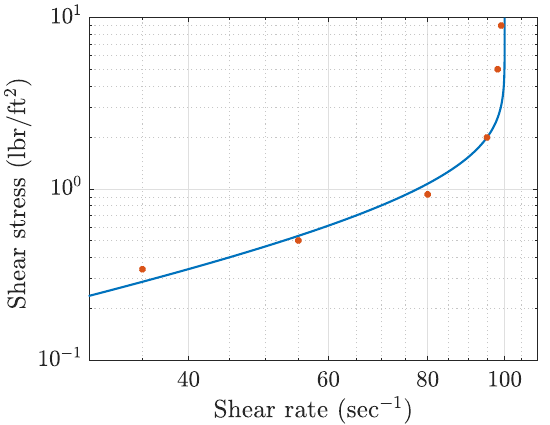
Figure 4. Flow curve (shear stress vs. shear rate) for TiO 2 suspension (47%), see Figure 2 in [1]. Experimental data (stars) and fitting curve (continuous). Fitting parameters a ∗ = 1.5 (ft 2 /lbr), b ∗ = 10 2 s − 1 .